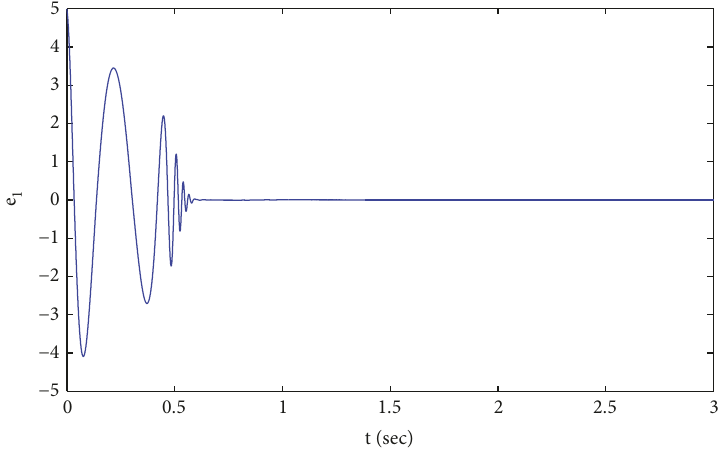
Figure 7: The time response of the error state 𝑒 1